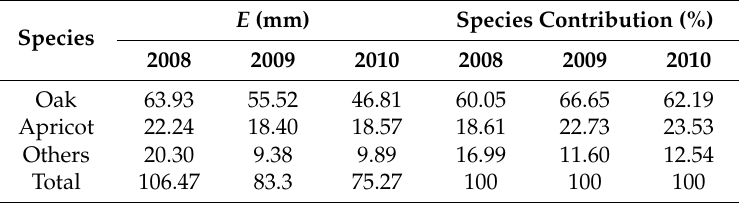
Table 3. Transpiration ( E ) and proportion of stand transpiration of different species in three years. E (mm) Species Contribution Species